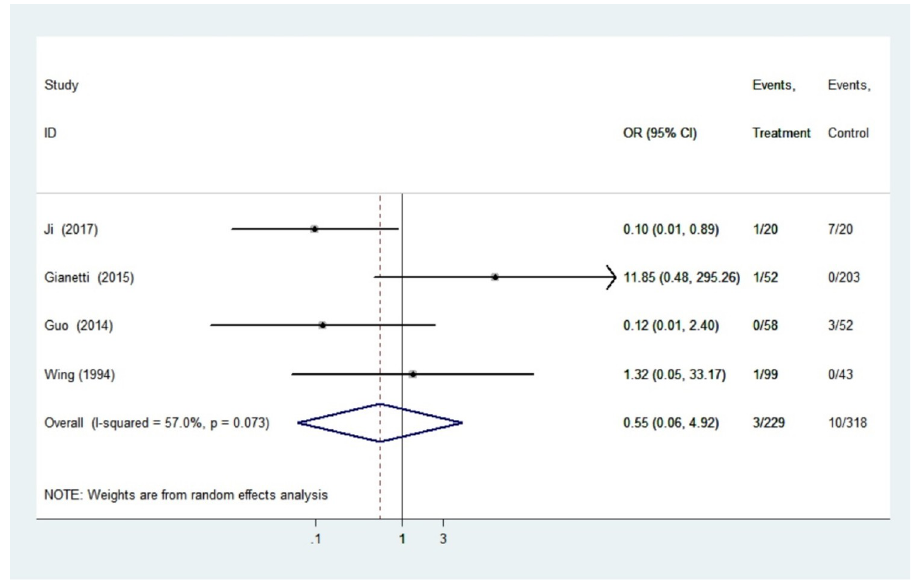
Fig 5. Forest plots of showing the effects of PTU on neonatal